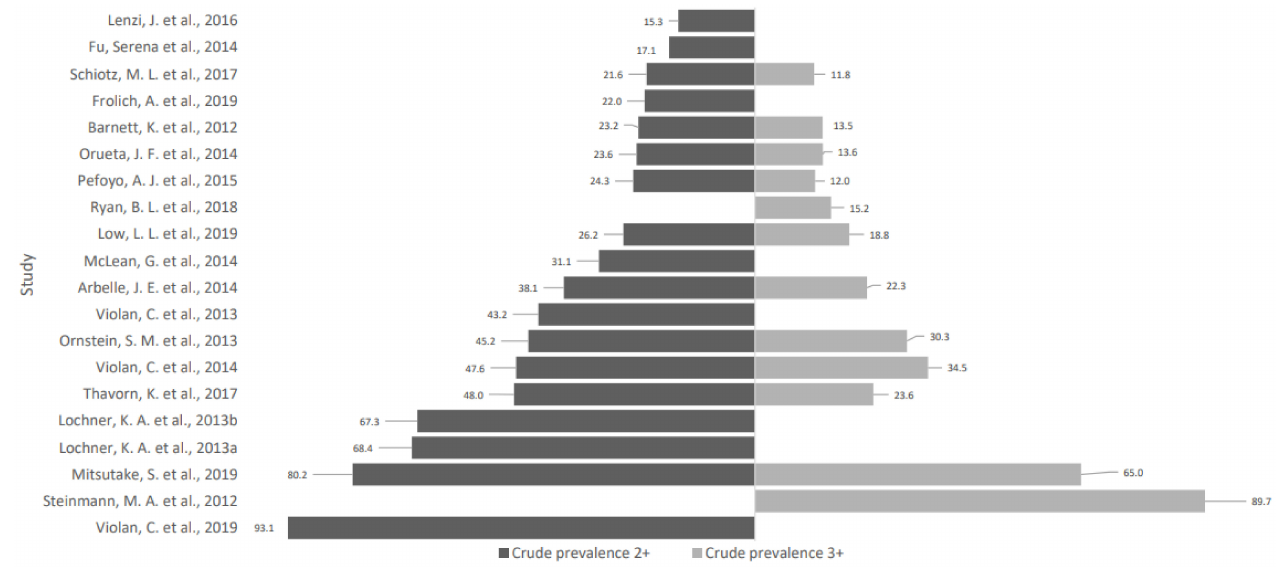
Figure 2. Crude prevalence of multimorbidity 2+ and